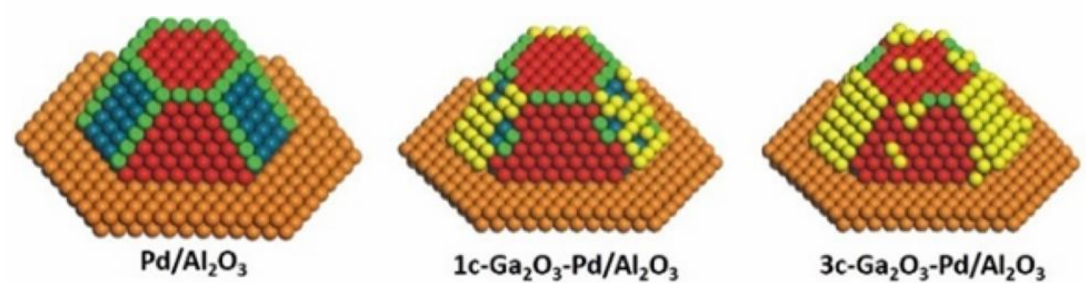
Figure 14. Schematic drawing of supported Pd particles in Pd/Al 2 O 3 - and Ga 2 O 3 -coated Pd particles in 1c-Ga 2 O 3 − Pd/Al 2 O 3 and 3c-Ga 2 O 3 − Pd/Al 2 O 3 . The red, blue, green, orange, and yellow spheres represent terrace atoms of Pd (111) facets, facets other than Pd(111), corner and edge atoms of Pd(111) facets, Al 2 O 3 , and Ga 2 O 3 , respectively (reproduced with permission from [273]. Copyright 2016, American Chemical Society).